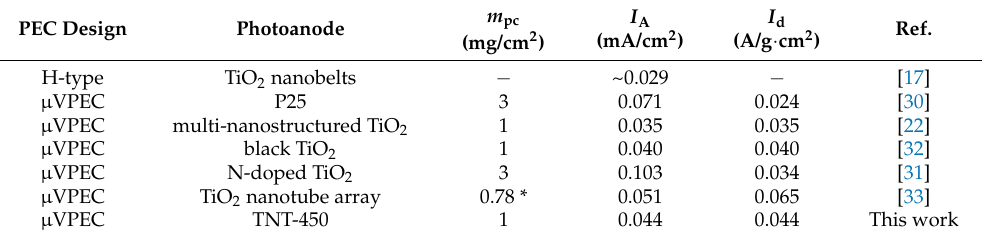
Table 1. Comparison of the photoelectrochemical